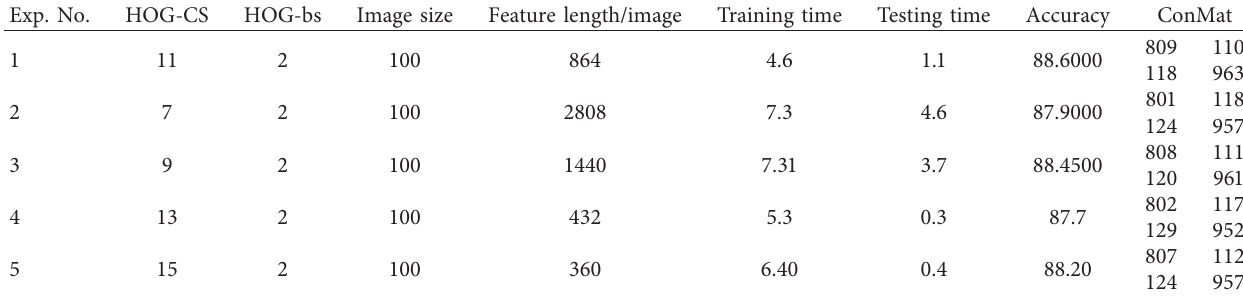
Table 2: HOG and SVM optimized parameters for training and testing with the LS learning algorithm. Exp. No.